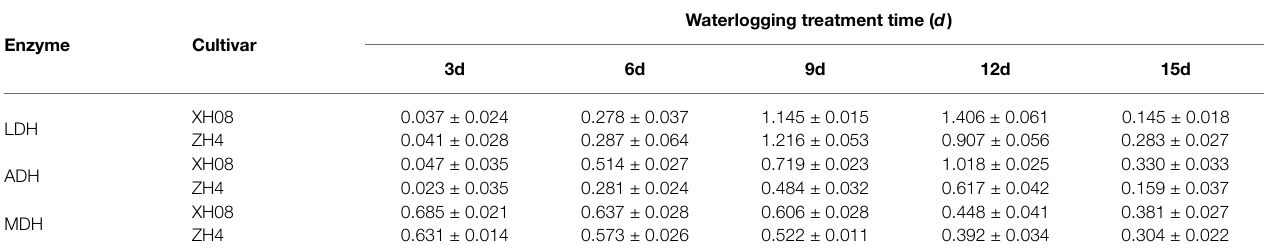
TABLE 2 | Enzymatic activities of LDH, ADH, and MDH in XH08 and ZH4 treated with waterlogging for 3, 6, 9, 12, and 15 days (U mg − 1 FW).